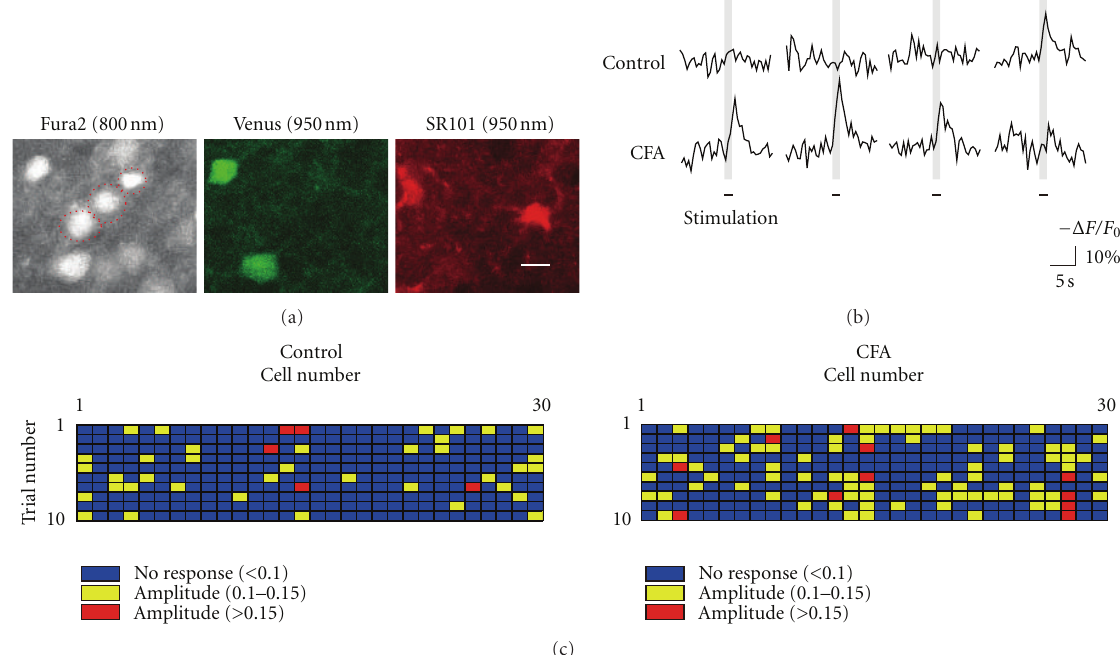
Figure 3: Enhanced activation of L2/3 excitatory neurons in response to hind paw stimulation and in response to stimulation of L4 neurons. (a) Identification of the S1 L2/3 excitatory neurons (red dotted circles in the Fura2 image), inhibitory neurons (green, Venus image), and astrocytes (red, SR101 image). Ca 2+ indicator (Fura2) was excited at 800 nm two-photon laser, whereas Venus and SR101 were excited at 950nm laser. Only cells that were positive for Fura2, but not for Venus and SR101, (i.e., excitatory neurons) were included in analysis. Each subpanel shows the same imaging area of the mouse S1 L2/3. (b) Representative traces of Ca 2+ transients in identified L2/3 excitatory neurons during the same intensity stimuli (mechanical stimuli of hind paw or electrical stimuli of L4 cells) under control conditions (top traces) and following CFA-induced inflammatory pain (lower traces). (c) Distribution of the amplitude of Ca 2+ responses to 10 successive stimuli in a sample of 30 L2/3 excitatory neurons under control conditions (left) and following CFA-induced inflammatory pain (right). (a–c) Reproduced and adapted, with permission, from [13].